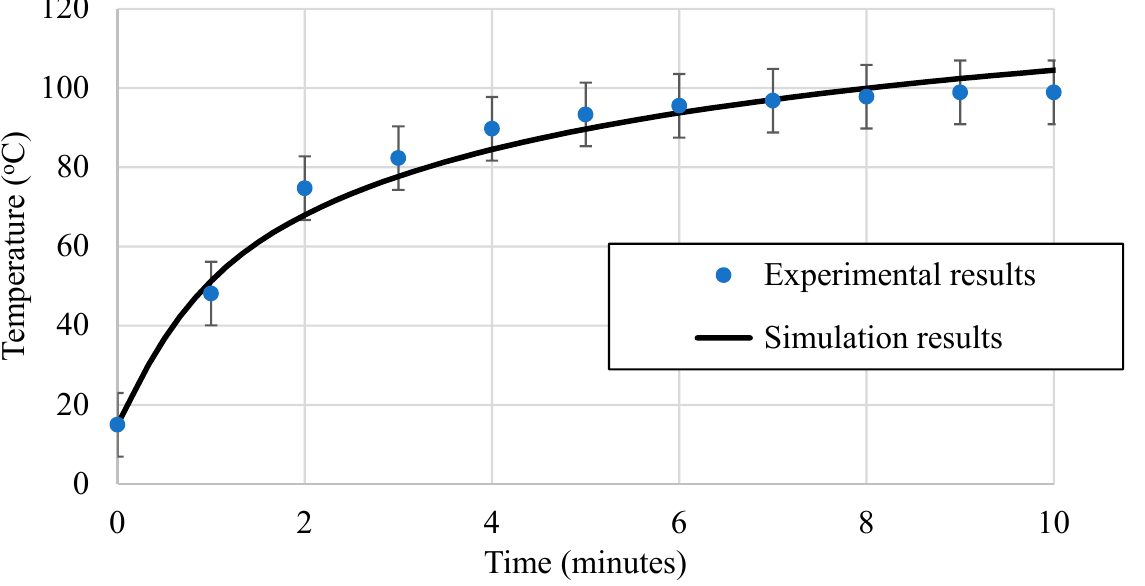
Figure 12. Comparison of temperature results as a function of time from simulation to experimental data reported in [35]. The input power corresponds to 30 W and a coolant flow rate of 1 g/s.